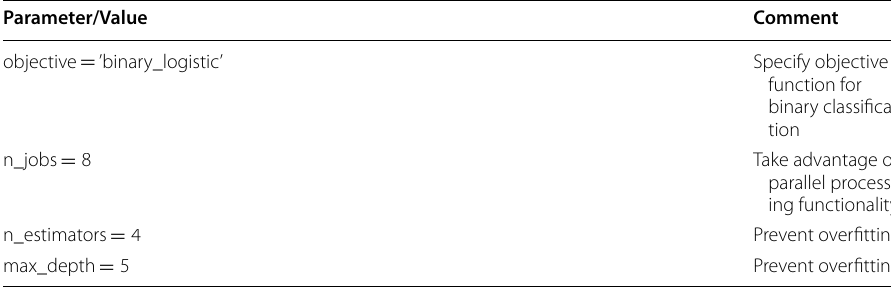
Table 14 XGBoost classifier initialization options